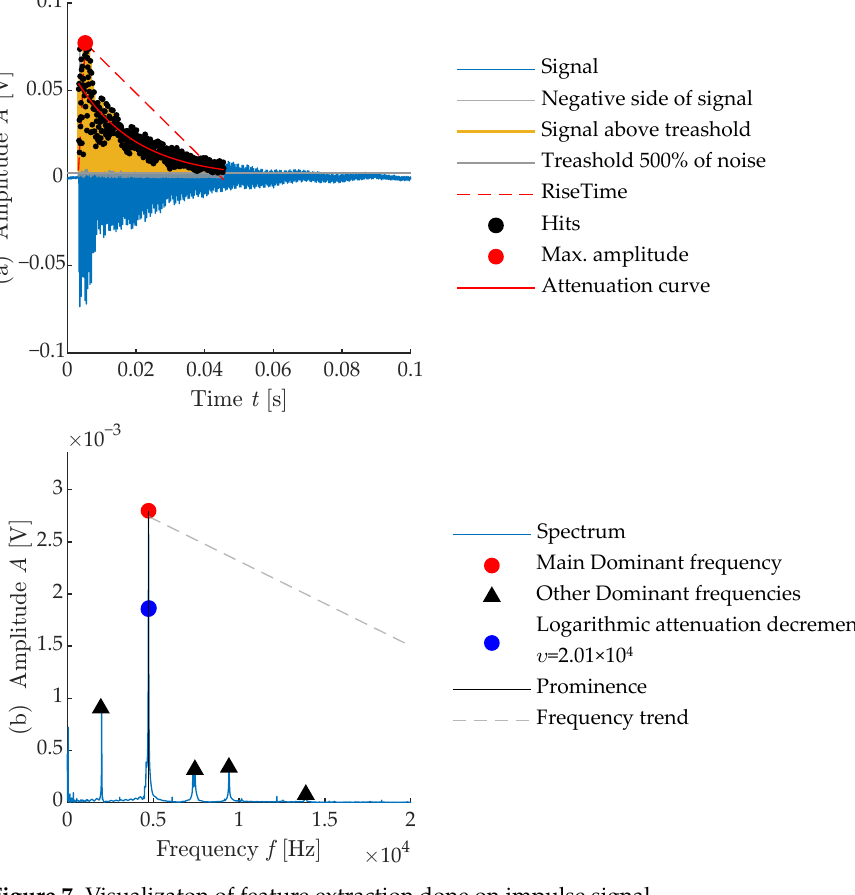
Figure 7. Visualizaton of feature extraction done on impulse signal.